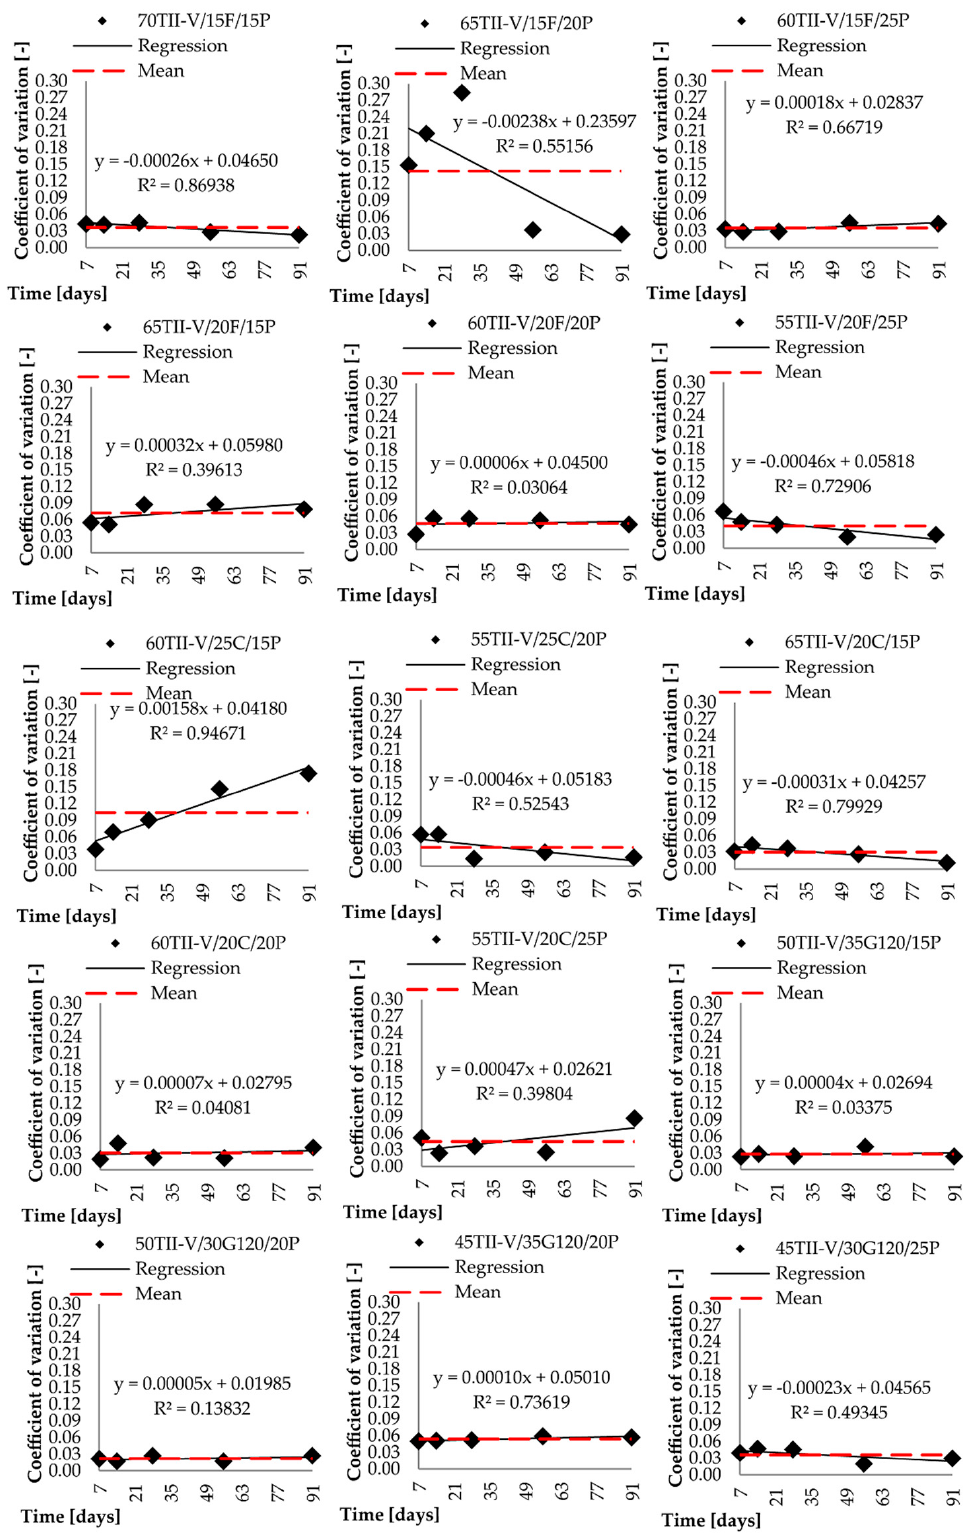
Figure 8. Comparison of experimental data with mean and linear regression approximations of variation coefficients for mixtures groups with fly ash class F, fly ash class C, and slag of grade 120.